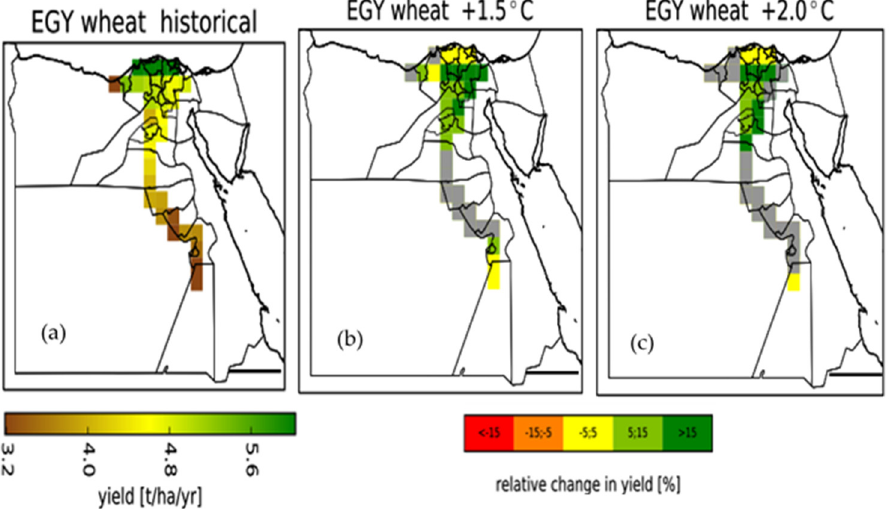
Figure 6. The historical wheat yield in the 2000s and the future ISI-MIP relative change under GW1.5 and GW2.0 levels, ( a ): EGY wheat historical; ( b ) EGY wheat +1.5 °C; ( c ): EGY wheat +2.0 °C. The grey grid cells where the models do not agree in the sign of change under each warming level, and this belongs to the uncertainty. Table 4. The change in national yield of wheat and maize under 1.5 °C and 2.0 °C levels of temper- ature change.